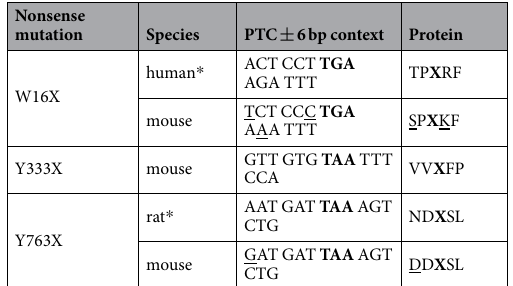
Table 1. Leptin receptor nonsense mutations. Three different point mutations resulting in the formation of premature termination codons (PTC) were investigated in the present study. All mutations were inserted into the murine receptor sequence to ensure a comparison within an identical genetic backbone. The mutation W31X was additionally investigated within the human sequence. Differences on the nucleotide and amino acid level are underlined. * Indicates the species in which the mutation was